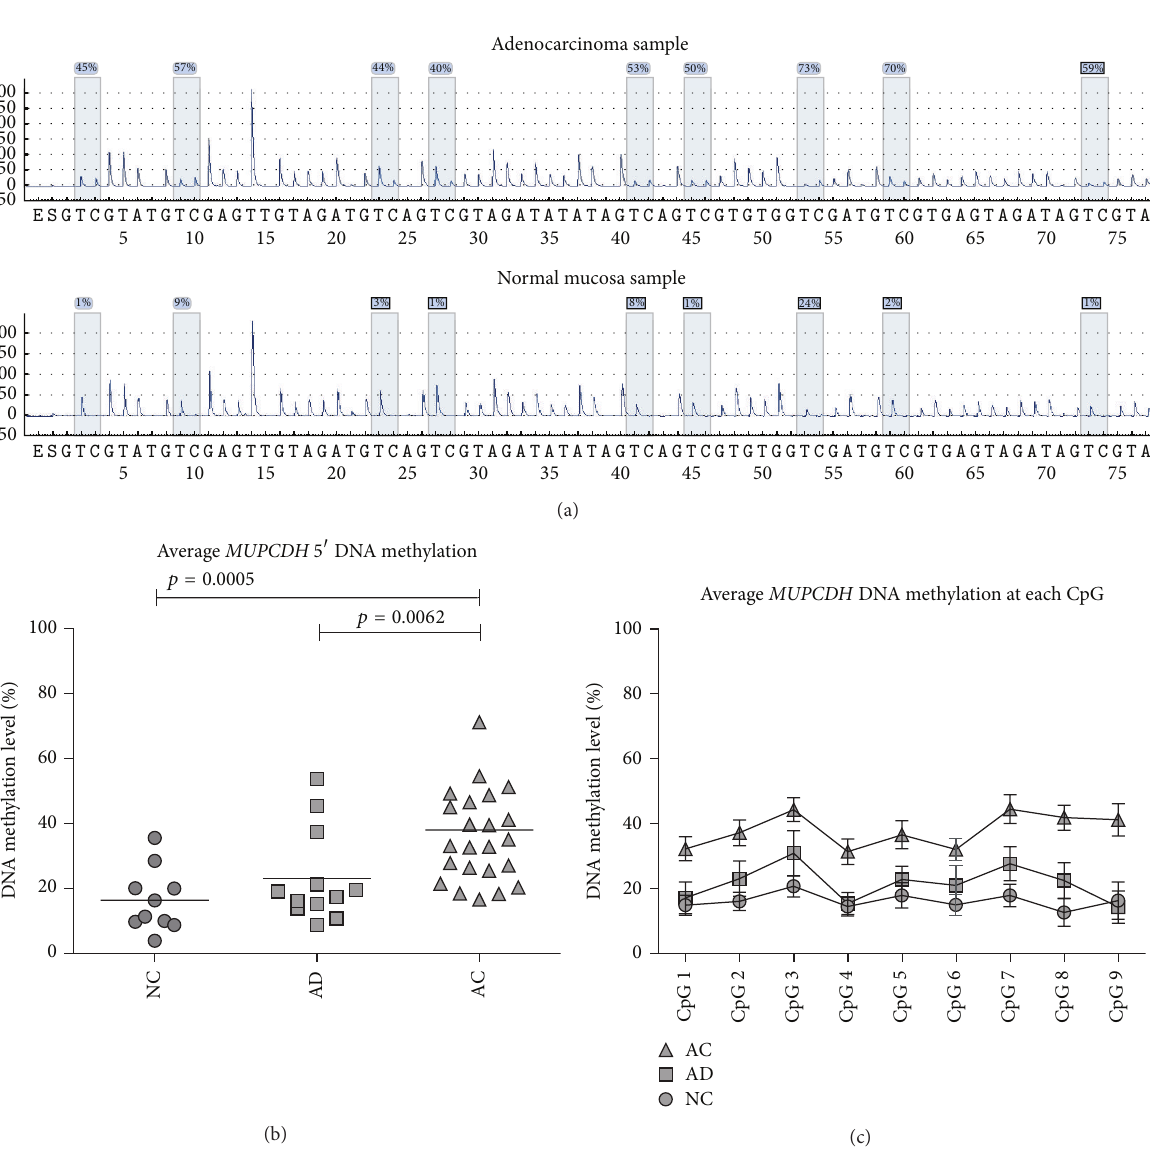
Figure 3: MUPCDH promoter DNA methylation results. (a) The examples of pyrosequencing results for individual adenocarcinoma and normal mucosa samples. (b) The average MUPCDH promoter DNA methylation in normal colonic mucosa (NC), adenomas (AD),